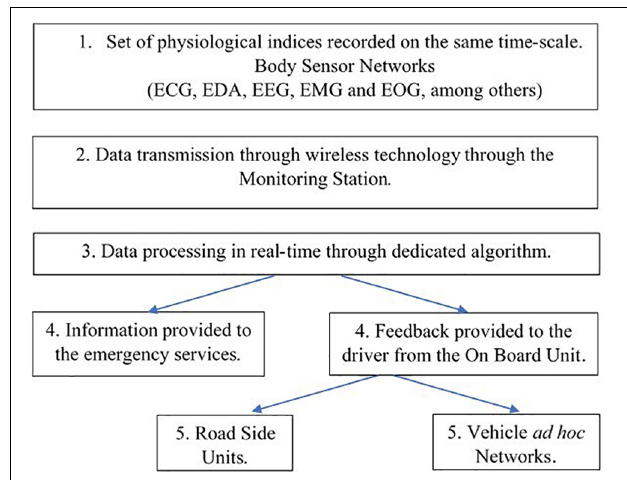
FIGURE 2 | Steps from recording the driver’s functional state through body sensors until informing the emergency services, the driver himself and the environment. Adapted from Reyes-Muñoz et al. (2016), with permission of the editorial board of the journal “Sensors.” ECG, electrocardiography; EDA, electrodermal activity; EEG, electroencephalography; EMG, electromyography; EOG,